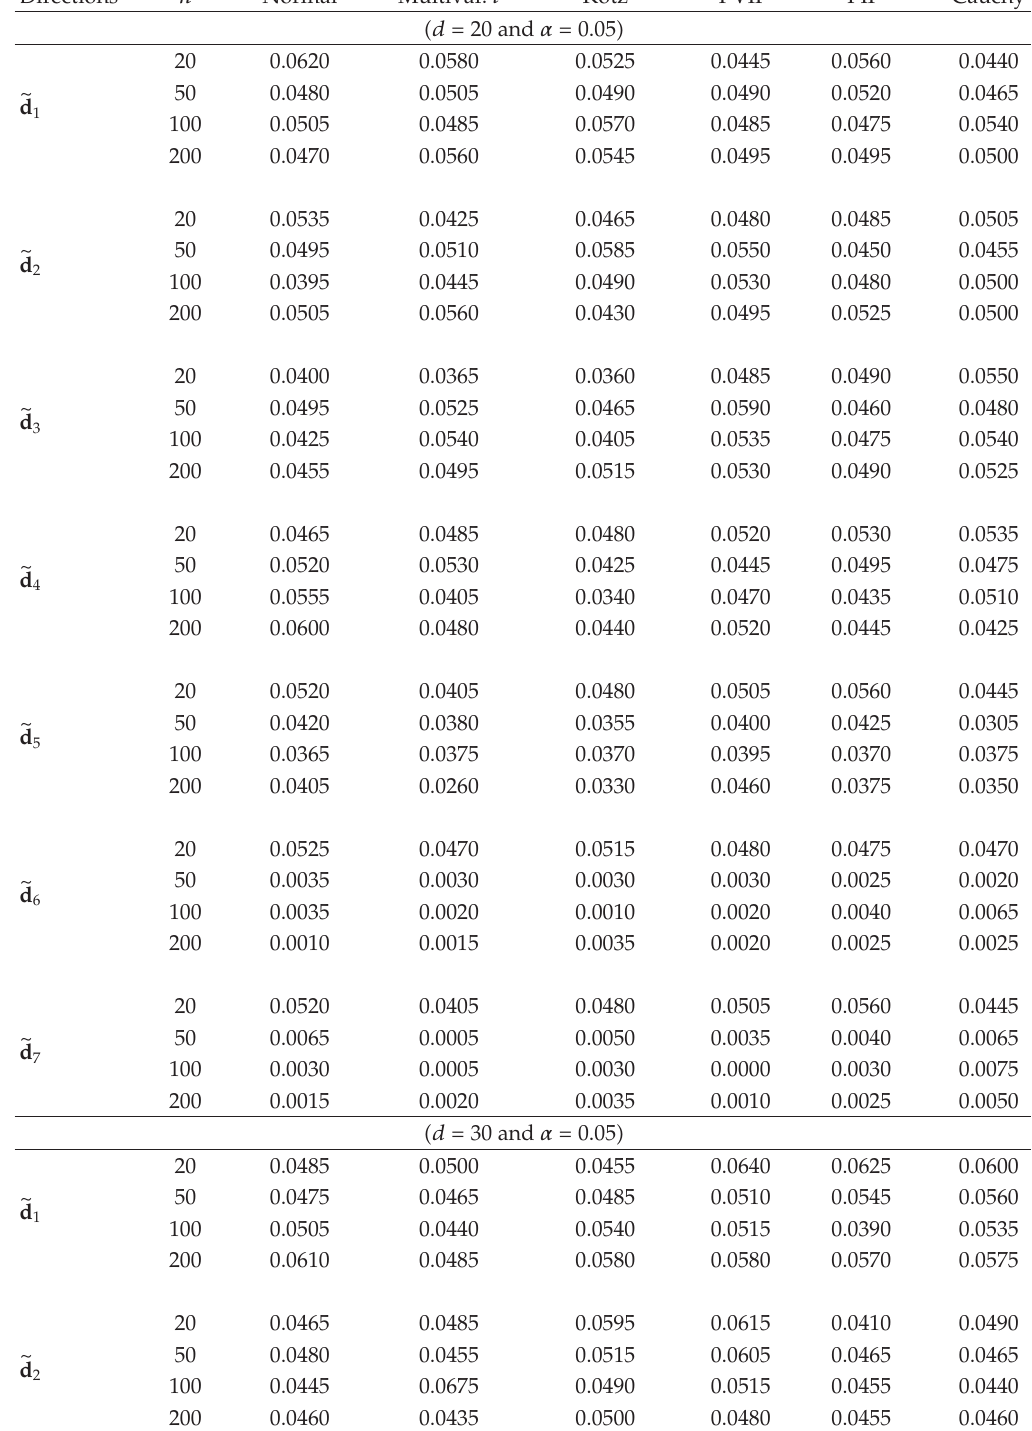
Table 1: Type I error rates of the ST 3 -plot for testing spherical